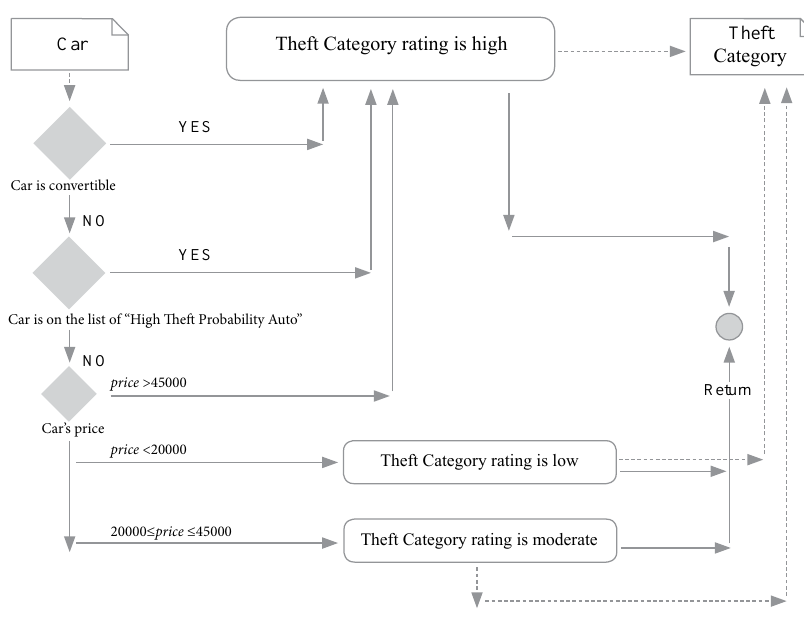
fig. 3. Business process of Potential Theft Category